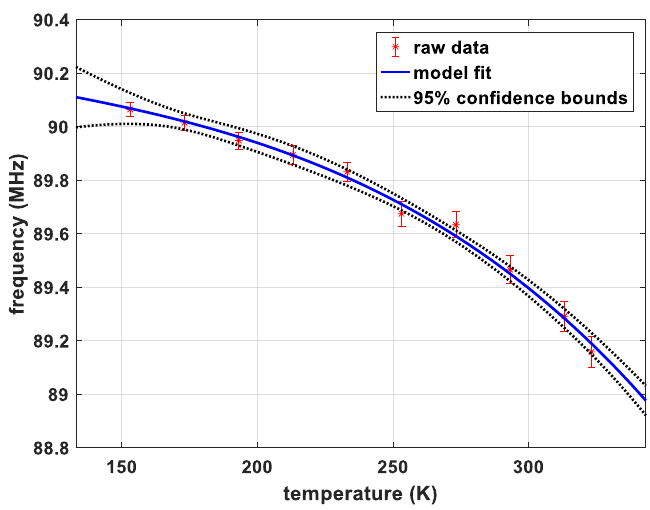
Figure 2. Temperature dependence of the transition frequency for sample CS, site A. Table 4. Parameters of the Bayer‘s model and calculated g-parameter by Brown’s method.